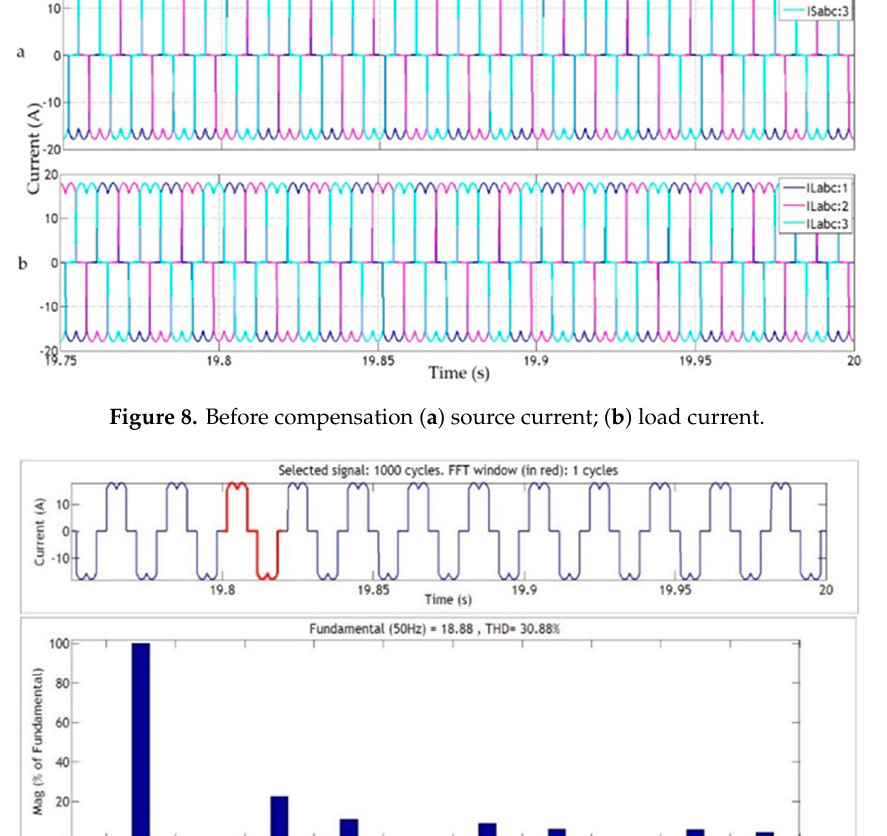
Figure 11. Transformed voltages ( a ) (cid:1874) (cid:3080) ; ( b ) (cid:1874) (cid:3081) . Figure 12. Transformed currents ( a ) (cid:1861) (cid:2961) ; ( b ) (cid:1861) (cid:2962) . These voltages and currents ( (cid:1874) (cid:3080) , (cid:1874) (cid:3081) and (cid:1861) (cid:3080) , (cid:1861) (cid:3081) ) are used to calculate the instantaneous active and reactive power. The instantaneous active power is passed through a high-order low-pass filter to extract the average component of the active power that is needed, along with the total reactive power to generate the reference current in the α - β coordinates. Furthermore, the generated compensation reference currents ( (cid:1861) (cid:2961)∗ , (cid:1861) (cid:2962)∗ ) are transformed from the α - β frame to the a-b-c frame ( (cid:1861) (cid:3028)∗ , (cid:1861) (cid:3029)∗ , (cid:1861) (cid:3030)∗ ). Figures 13– 15 show the Simulink model of the reference compensation currents’ generation, and their waveforms in the α - β and a-b-c frames, respectively.